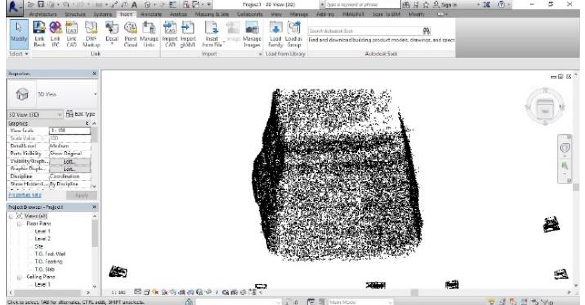
Figure 2. Revit interface hosts a point